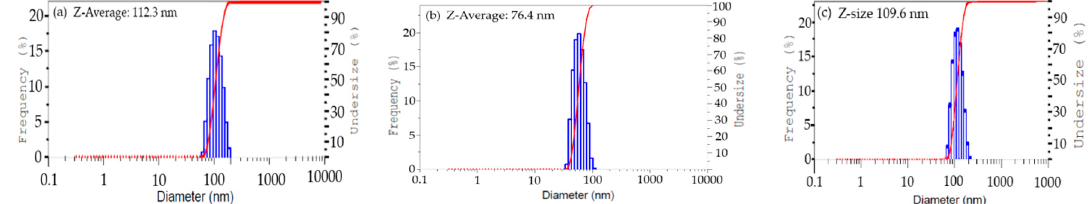
Figure 7. Dynamic Light Scattering (DLS) results of silver nanoparticles prepared by mixed gelatin (0.2%, w/v)-chitosan (0.06%, w/v) solution at ( a ) pH 4.0, ( b ) pH 6.0, and ( c ) pH 8.0.